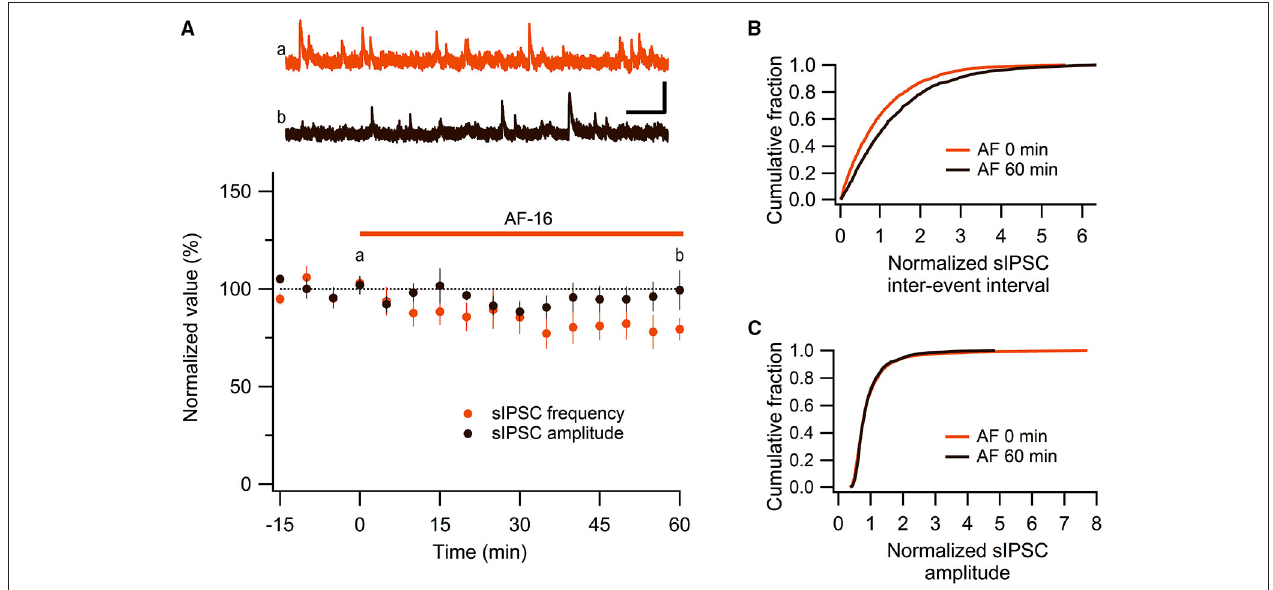
(dark brown trace 60 min after the application of AF) are shown at the top, scale bar represents 40 pA and 1 s. (B) Effect of AF-16 on the cumulative distribution of sIPSC inter-event intervals ( n = 8). (C) Effect of AF-16 on the cumulative distribution of sIPSC amplitudes ( n =